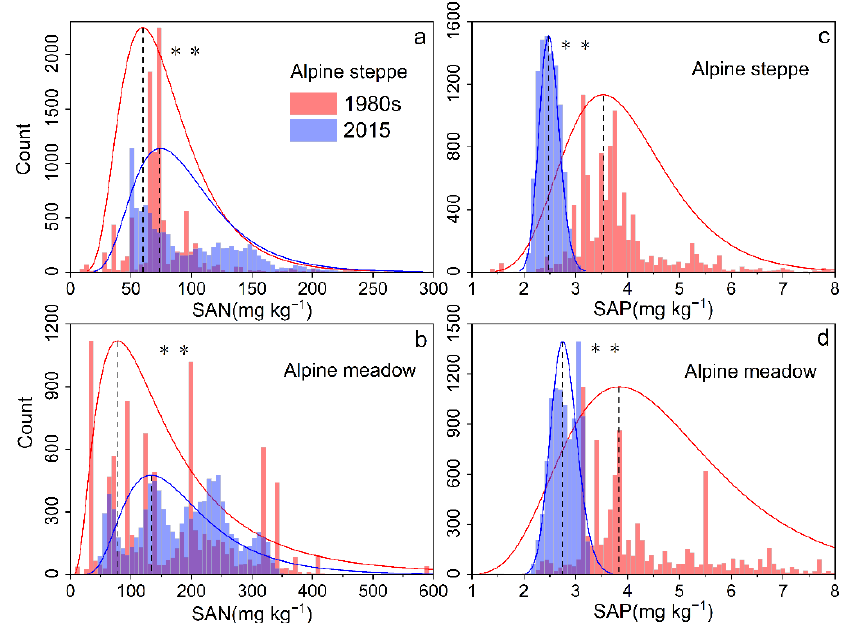
Figure 6. Histogram over the 1980s and 2015 for SAN steppe ( a ), SAN meadow ( b ), SAP steppe ( c ), and SAP meadow ( d ). The asterisk (* *) indicates a significant difference between the 1980s and 2015 at P < 0.01.